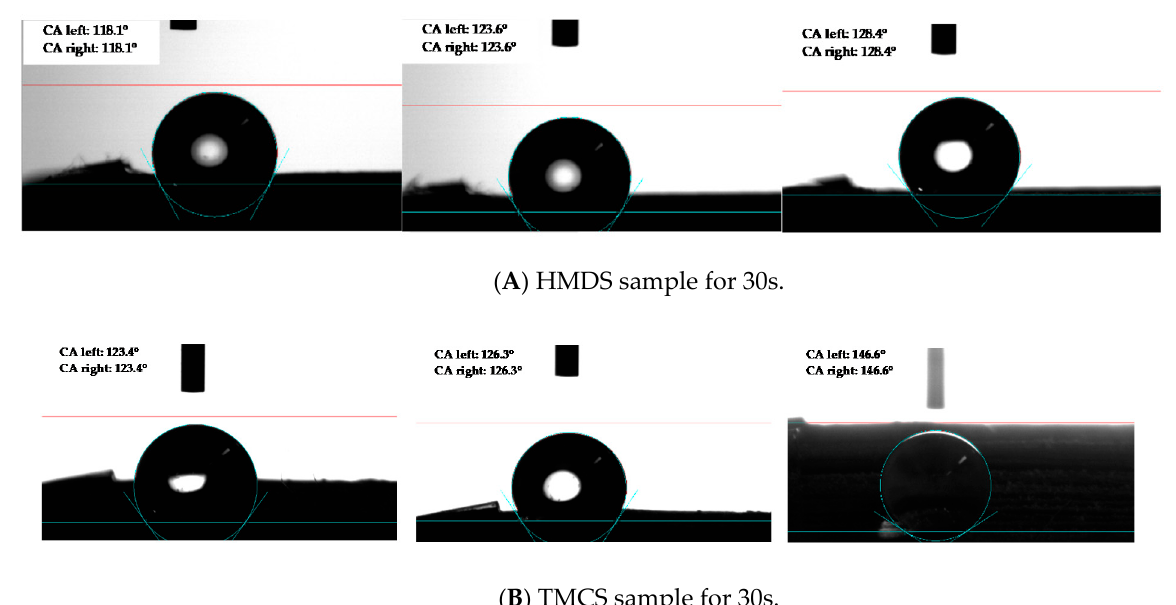
Figure 20. Contact angle of sample after the sand abrasion test for 30s ( A ) HMDS and ( B ) TMCS at mounted 45°.